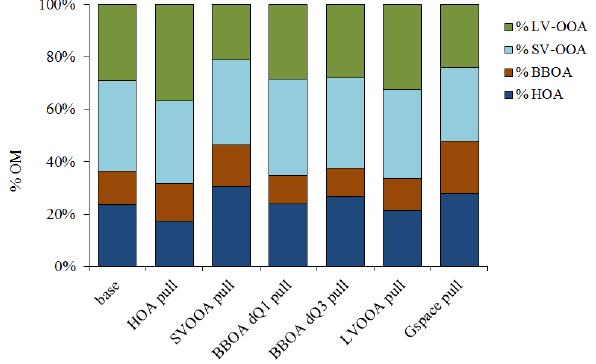
Figure 11. Attribution of OM with four factors for base run (base); ratio of m/z 41/43 in the 3 Fig. 11. Attribution of OM with four factors for base run (base); HOA profile pulled toward the diesel exhaust profile (HOA pull); ratio of m/z 43/44 in the SV-4 ratio of m/z 41/43 in the HOA profile pulled toward the diesel ex- OOA profile pulled toward the 5-hour aged diesel profile (SVOOA pull); ratio of m/z 60/91 in 5 haust profile (HOA pull); ratio of m/z 43/44 in the SV-OOA profile pulled toward the 5-h aged diesel profile (SV-OOA pull); ratio of the BBOA profile pulled toward the oak-flame source profile with different dQ values (BBOA 6 m/z 60/91 in the BBOA profile pulled toward the oak-flame source dQ 1 and 3 pull); m/z 44 in LV-OOA profile pulled up maximally (LVOOA pull); and edge 7 profile with different dQ values (BBOA dQ 1 and 3 pull); m/z 44 points on the HOA/LV-OOA G-space plot pulled down to the y- and x-axes (G space pull). 8 in LV-OOA profile pulled up maximally (LV-OOA pull); and edge points on the HOA/LV-OOA G-space plot pulled down to the y- and x-axes (Gspace